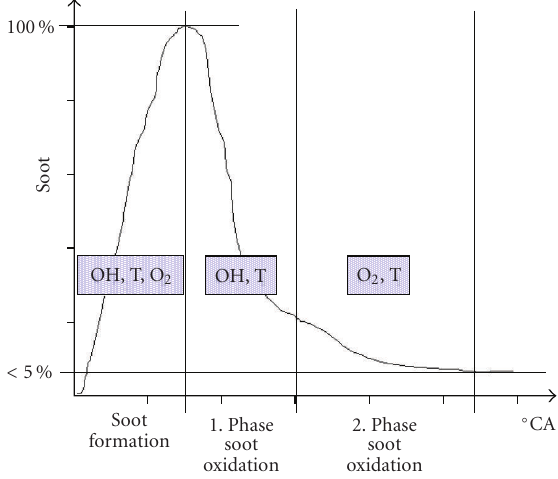
Figure 2: Qualitative characteristic process of the soot formation and oxidation [6,